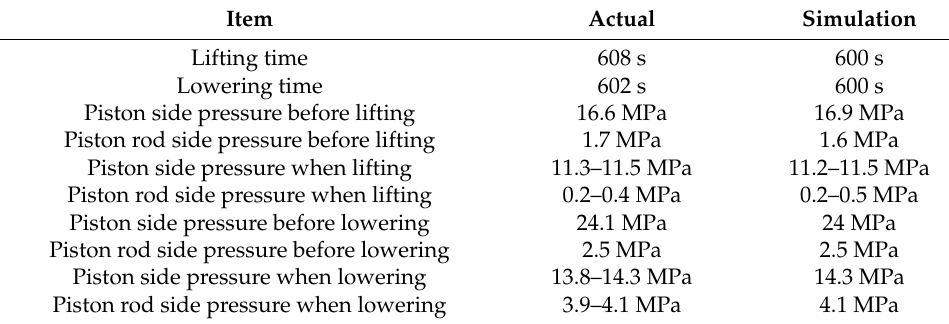
Table 3. Comparison of